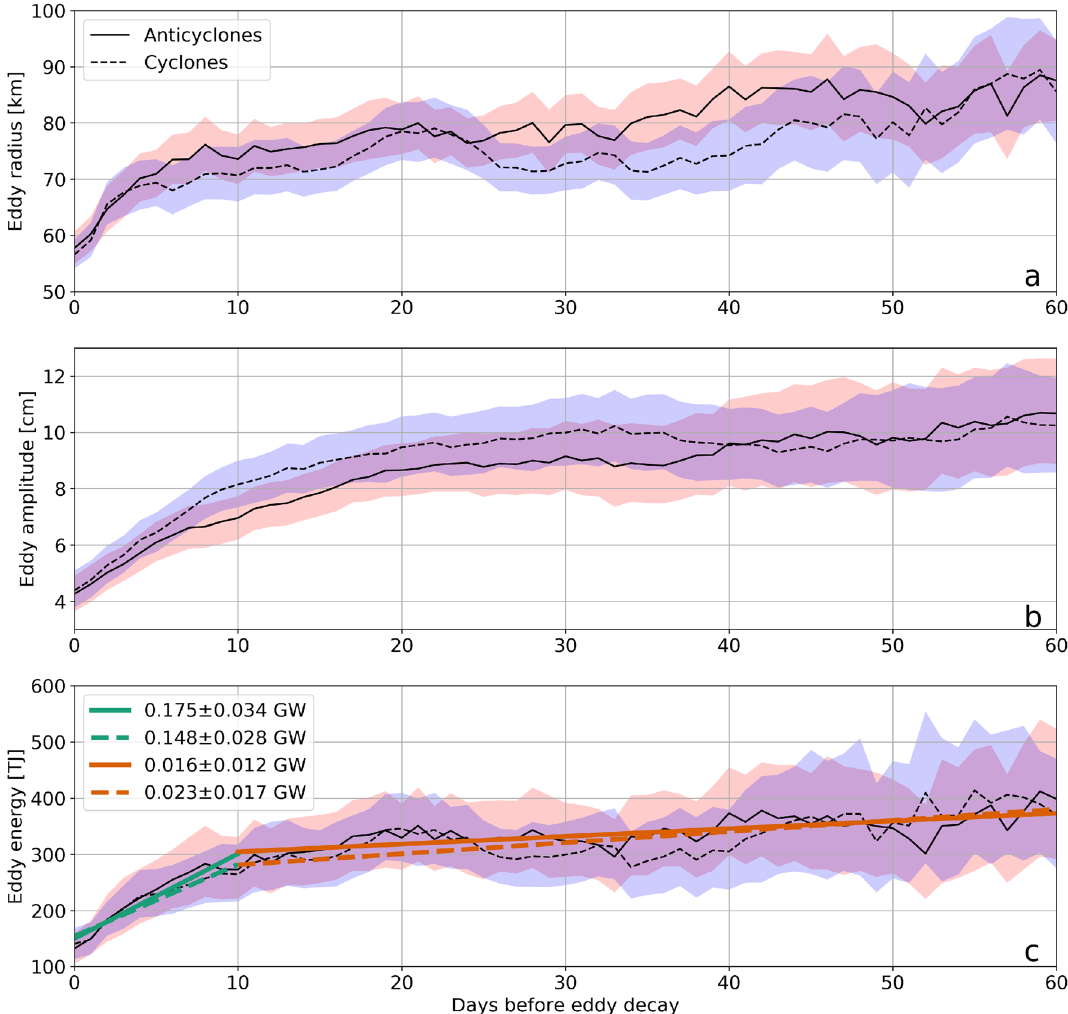
Figure 6. Mesoscale eddy decay rate. ( a ) Mean eddy radius of anticyclonic (red) and cyclonic (blue) eddies that dissipate within the MerMEED study region, shown as a function of days before decay. The shading represents an estimate of the uncertainty in the eddy radius calculated using Monte-Carlo based bootstrapping. ( b ) As in ( a ) but for eddy amplitude. ( c ) As in ( a ) but for eddy kinetic energy. The coloured lines are a linear fit to the eddy kinetic energy curves for the intervals 0–10 days before decay and 10–60 days before decay. The gradient of each coloured line is shown in the legend where the uncertainty range is estimated from the mean difference between the gradient of the upper and lower bounds (represented by the shading) and the central